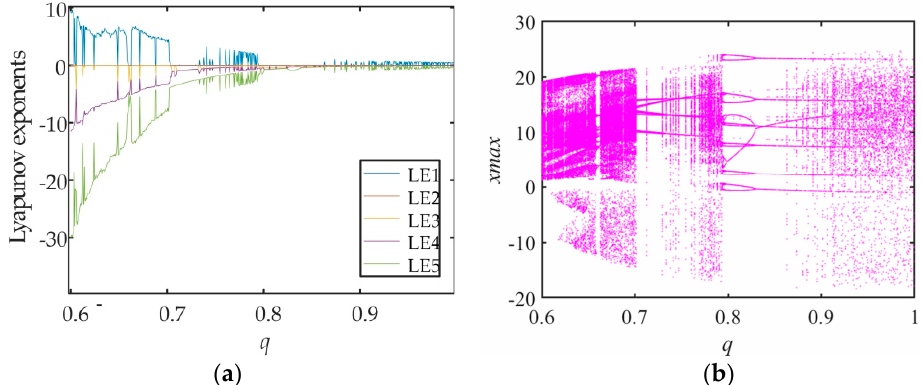
Figure 9. Lyapunov exponent spectrum and bifurcation diagram with order q , ( a ) Lyapunov exponent spectrum, ( b ) bifurcation diagram.